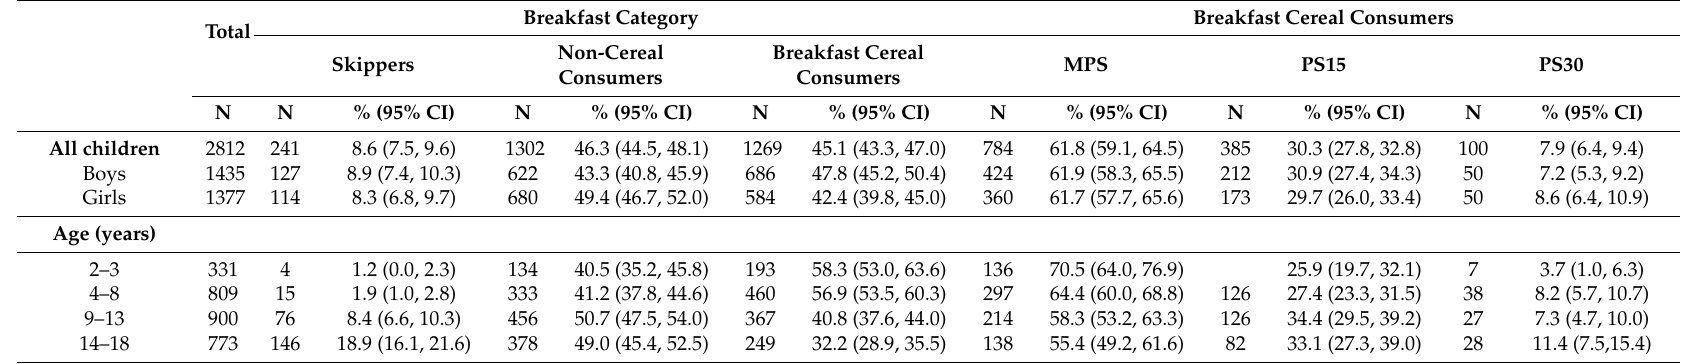
Table 1. The weighted percentage of children and adolescents, 2–18 years by breakfast * consumption and breakfast cereal type based on the 2011–2012 National Nutrition and Physical Activity Survey ( n =